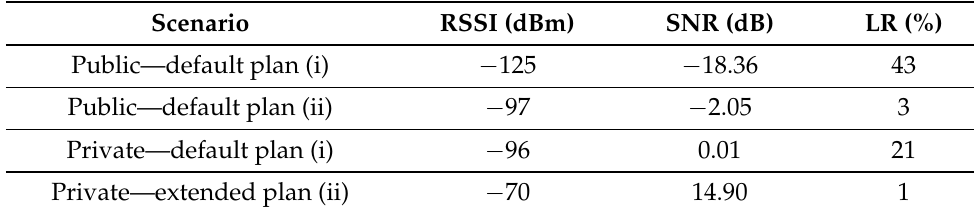
Table 3. Effect of the plan on performance (arithmetic